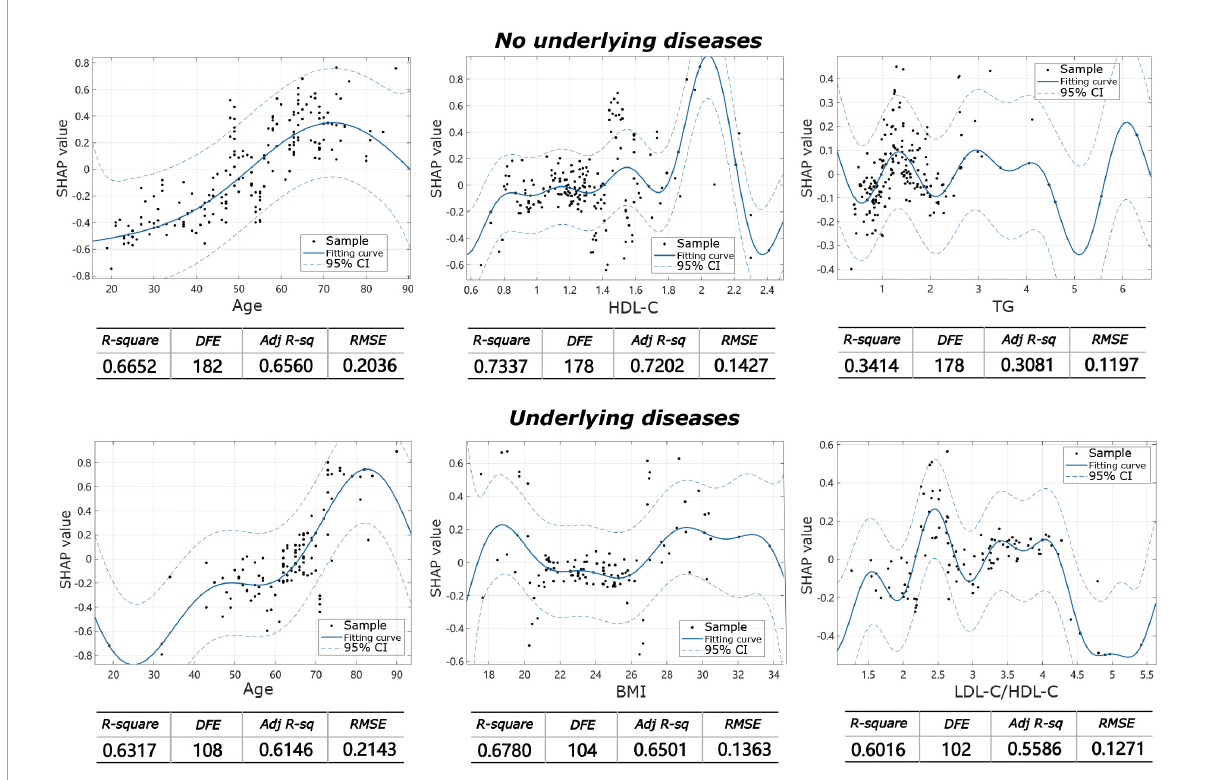
FIGURE4 Fitting effect curves show the association between SHAP values and contributing factors in